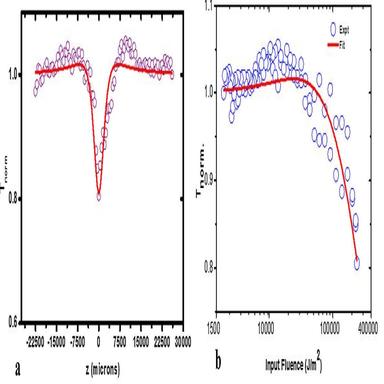
(a) Open aperture Z-scan curve of PCOH (b) Variation of normalized transmittance with input laser fluence.